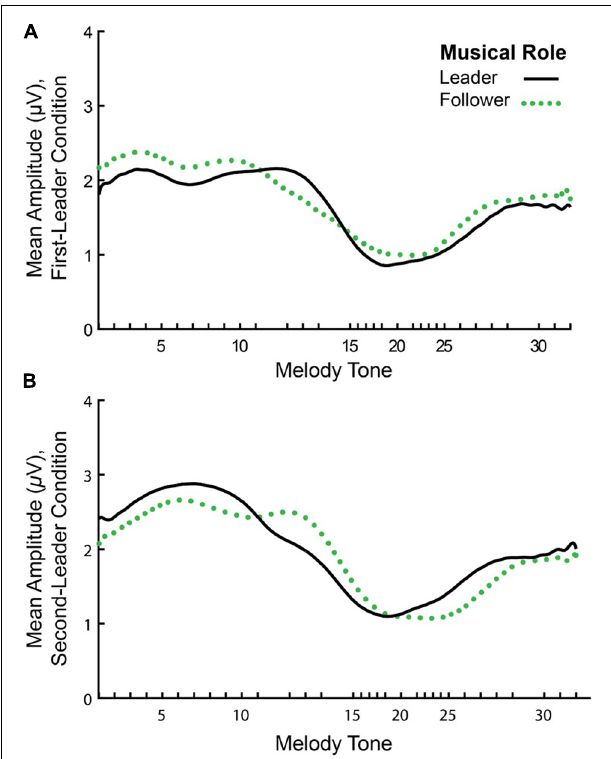
FIGURE 6 | Mean amplitude envelopes of one pair’s neural oscillations at the Duet performance rate. Timecourse of amplitude fluctuations in spectral energy at the Duet performance rate for a sample pair in the First-Leader (A) and Second-Leader (B) conditions. In each condition, the Leader’s mean amplitude envelope across 24 melody performances is shown in black (solid line) and the Follower’s mean amplitude envelope is shown in green (dotted